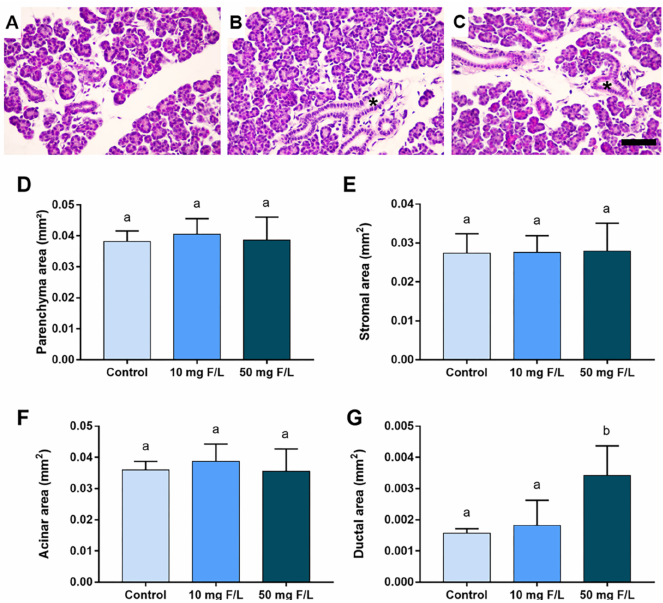
Figure 2. Histological image and morphometric analysis of the tissues that comprise the parotid glands of the offspring indirectly exposed to water containing 0 (control), 10, or 50 mg F/L for 42 days ( n = 5 animals/group). ( A – C ) represent parotid of the 0 (control), 10 mg F/L, and 50 mg F/L groups, respectively; in ( D ), parenchyma area (mm 2 ); in ( E ), stromal area (mm 2 ); in ( F ), area of acini (mm 2 ); in ( G ), duct area (mm 2 ). Quantitative results are expressed as mean ± standard error of mean, one-way ANOVA with Tukey’s post-test. Different letters represent statistical difference ( p < 0.05). The asterisks indicate the location of the ducts. Scale bars: 10 µ